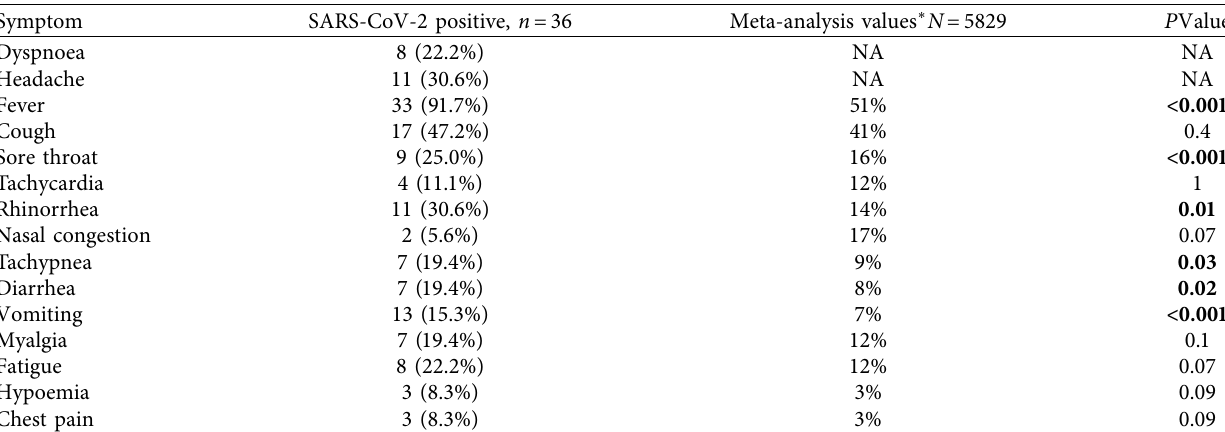
Table 3: Comparison of symptoms of positive patients with the percentages obtained in the meta-analysis of Cui (2019).